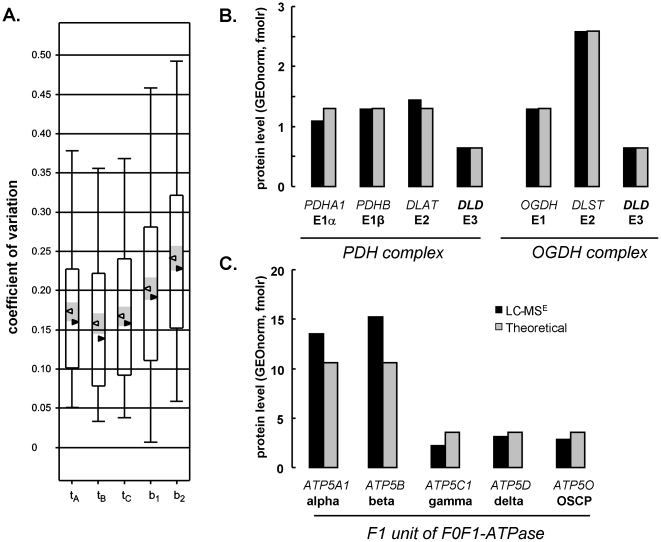
Validity of LC-MS quantifications.
A. Imprecision (error): beta cell proteins of 3 independent cell isolations (A, B, C) were injected in triplicate. Box and whiskers plots tA, tB and tC represent analytical variation on technical replicate LC-MS injections. Median and average values are represented by black and white triangles, respectively, with 95% confidence interval shown in grey. Total experimental imprecision (analytical + biological variation) is shown in b1 (normalized here for Gapdh) and b2 (total amount normalization). B–C. Accuracy (bias) was evaluated taking stoichiometry of multienzyme complexes as reference. Bar graphs represent geometrically-normalized protein levels (black bars, mean of n = 3) of indicated enzyme subunits measured by LC-MS in liver tissue; corresponding NCBI gene symbols are mentioned in italic capitals. Gray bars shows expected complex stoichiometry based on literature consensus. Panel B shows related pyruvate dehydrogenase (PDH) and oxoglutarate dehydrogenase complexes (OGDH). Panel C shows F1 unit of mitochondrial F0F1 ATP synthase. BCKD E2 subunit was absent in protein search library.